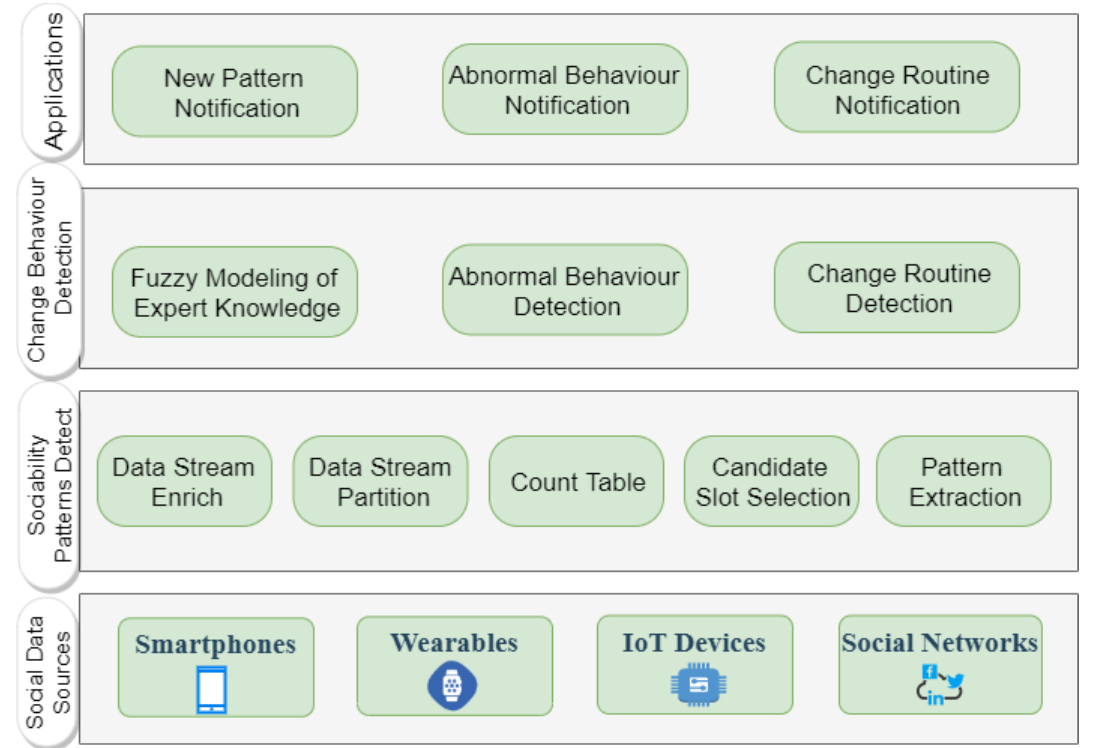
Figure 1. Components of the proposed